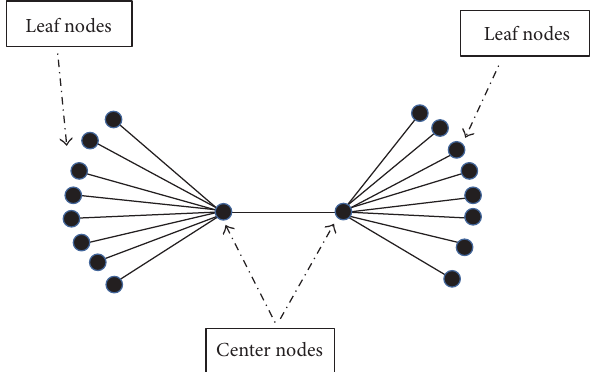
Figure 21: Star-composed network ( 𝑛 = 2 , 𝑘 = 8